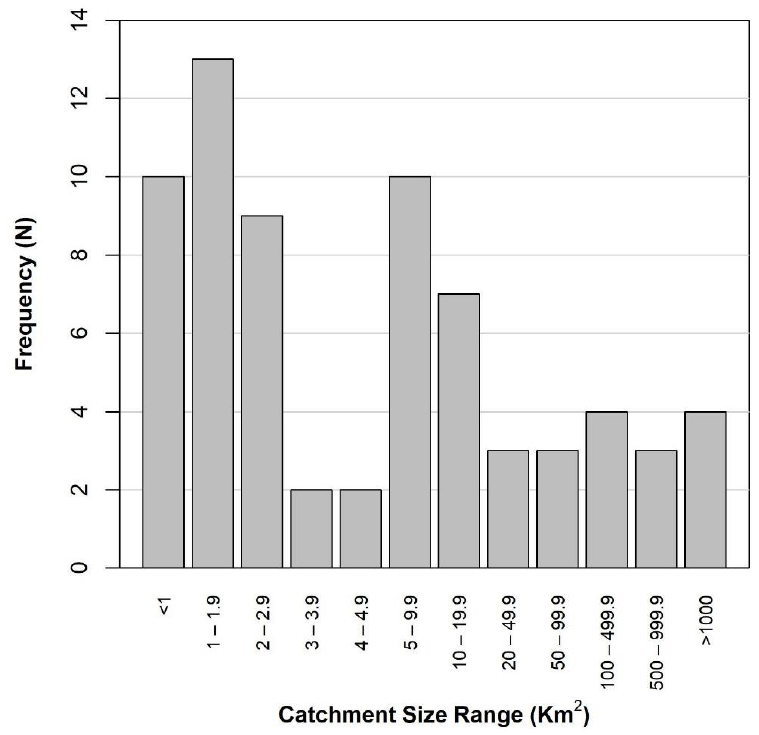
Figure 3. Frequency of surface water catchment sizes upstream from the point of Group Water Scheme abstraction.